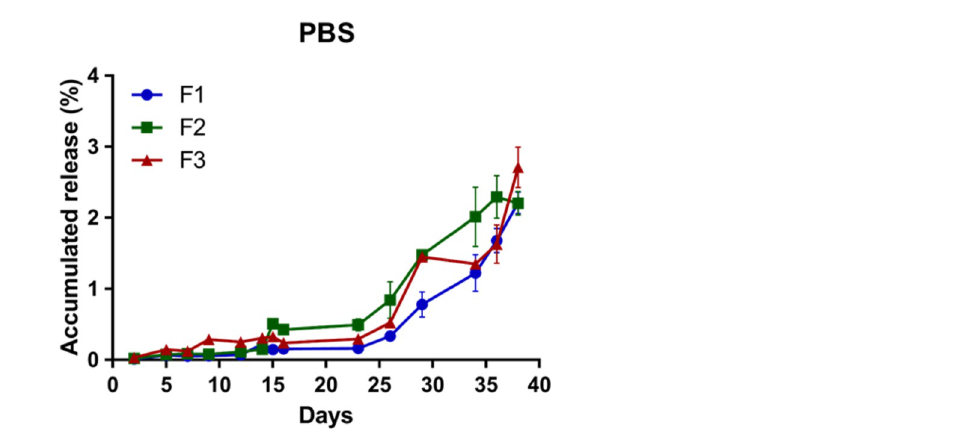
Figure 6. Dox release was slow before day 20 in PBS in F1, F2 and F3, surged after day